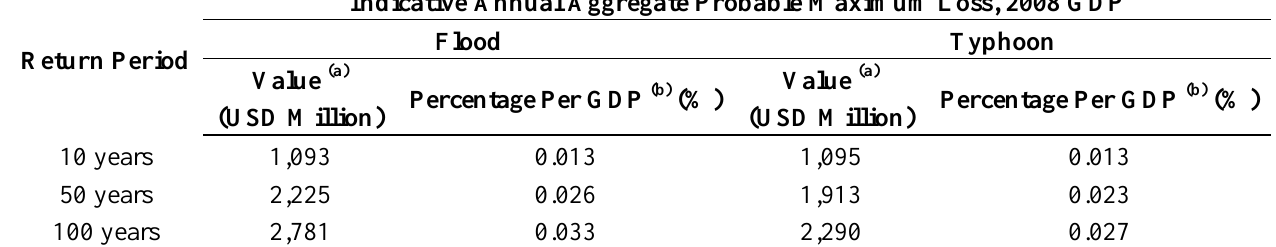
Table 4. Probability of flood and storm losses for the whole of Vietnam. Sources: